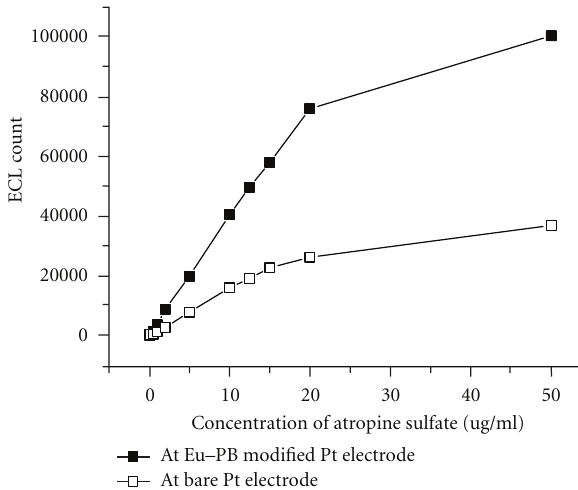
Figure 2: Di ff erential pulse voltammograms of Ru(bpy) 32+ in phosphate bu ff er (pH 8.0): (a) at bare Pt electrode; (b) at Eu-PB modified Pt electrode. Amplitude: 0.05 V; pulse width: 0.05 s; pulse period: 0.2s. Concentrations: Ru(bpy) 32+ , 5mM; phosphate bu ff er, 80mM.